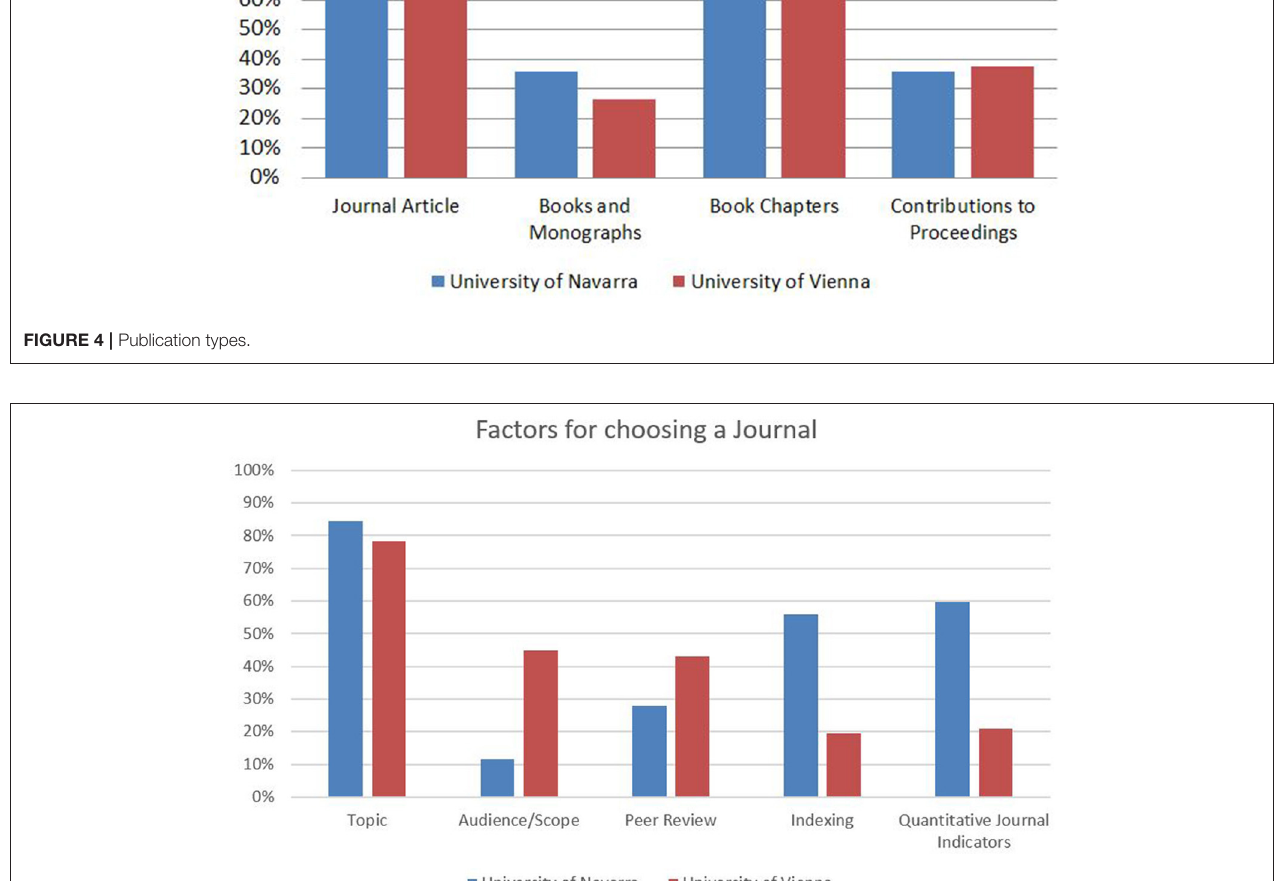
FIGURE 5 | Factors for choosing a